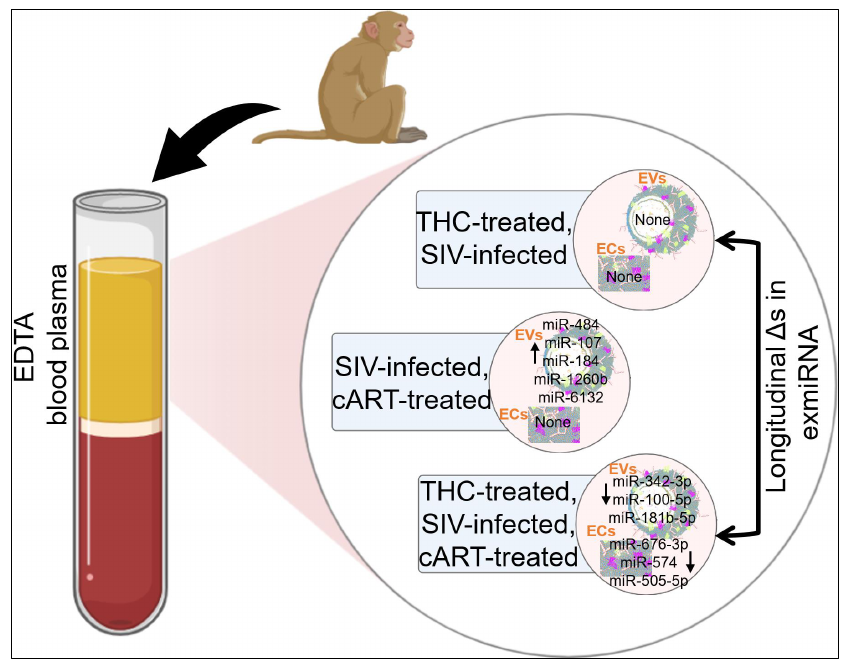
Figure 8. Circulating blood plasma miRNAs and their association with EVs and ECs in SIV-infected rhesus macaques under various treatments — THC, ART, THC, and ART. Parts of this illustration was created with BioRender.com.